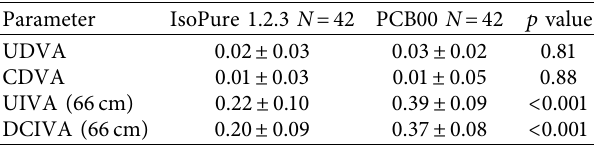
Table 2: One month postoperative monocular visual outcomes.